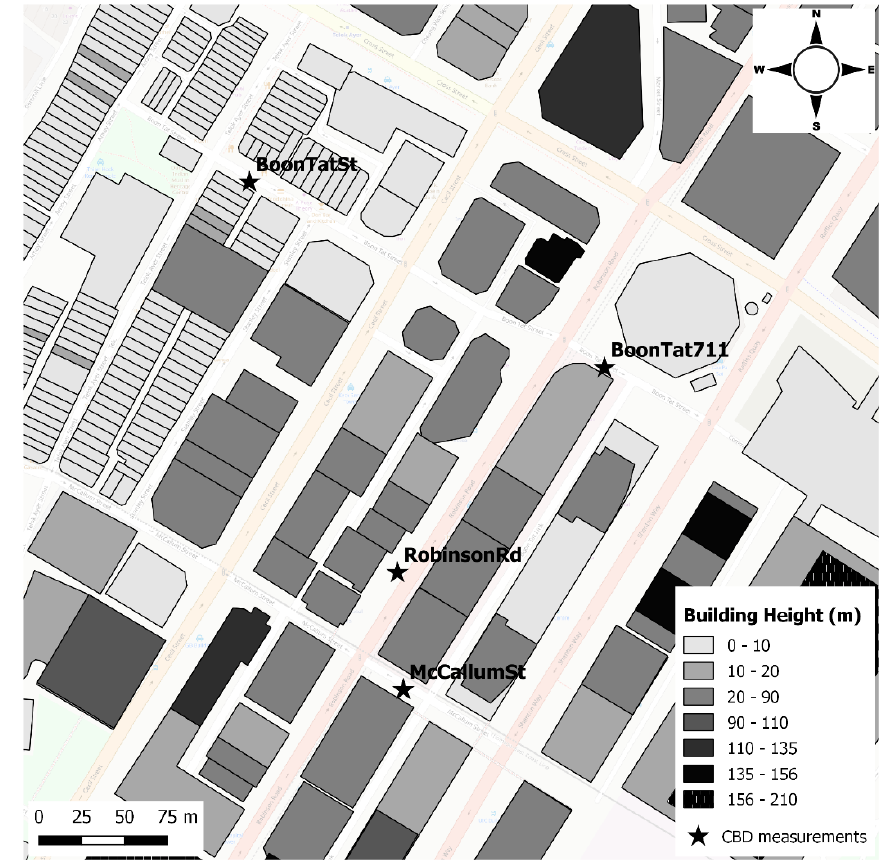
Figure 4. Location of the selected sites for the measurement campaign in the CBD area.